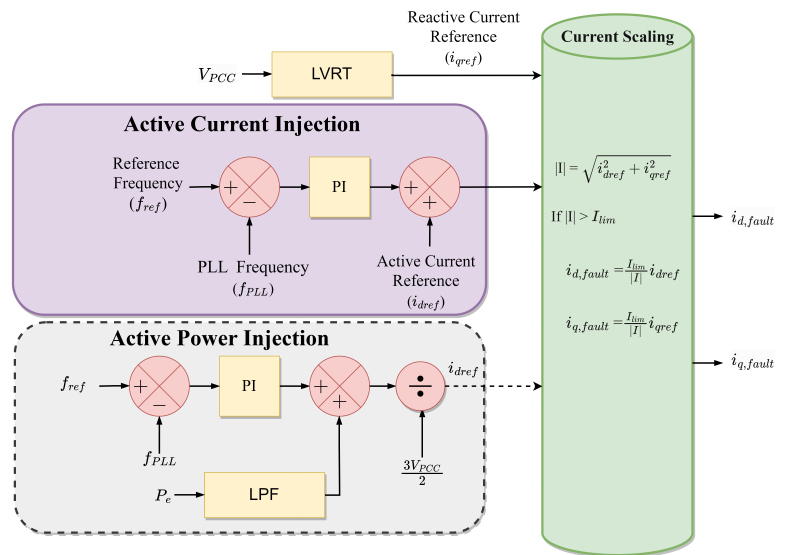
Figure 10. PLL frequency-dependent active current injection (solid block) [105] and active power injection (dashed block)